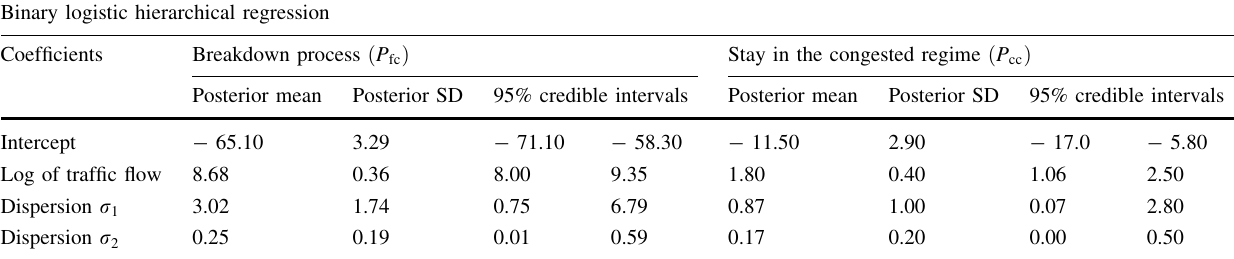
Table 2 Parameters posterior distributions summaries for Site 1 models Binary logistic hierarchical regression